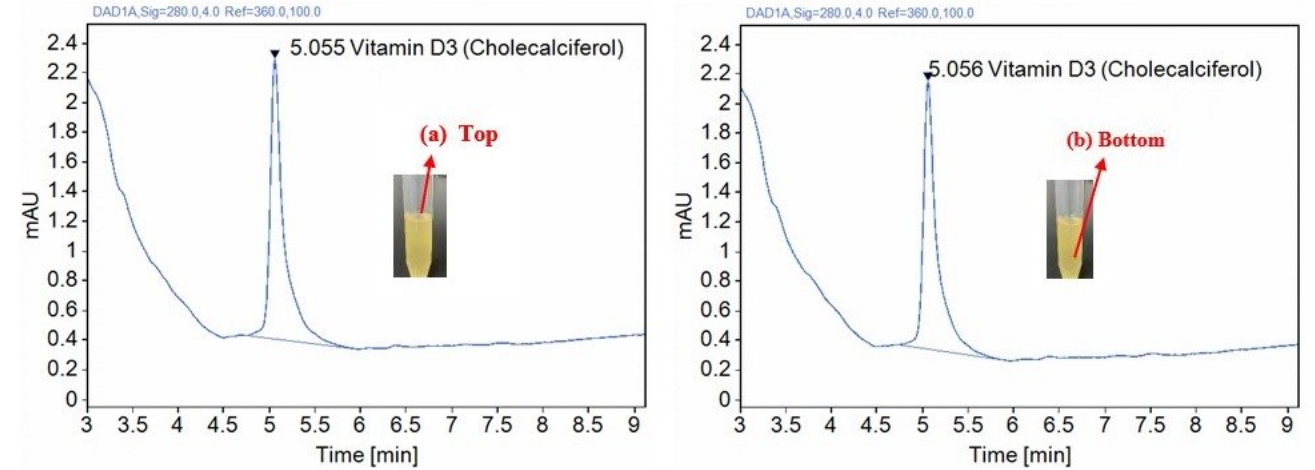
Figure 3. Representative liquid chromatograms obtained using UHPLC–DAD for liposomal vitamin D3 sampled from the two sample regions shown in the insets: Top ( a ) and Bottom ( b ).